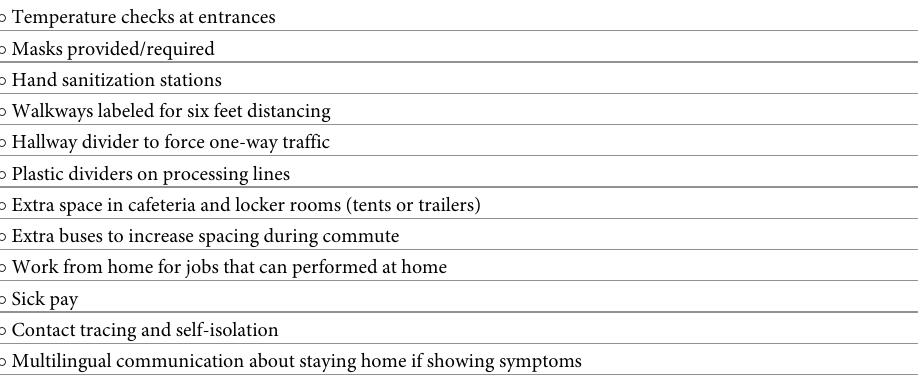
Table 2. List of mitigation measures utilized by some or all plants.